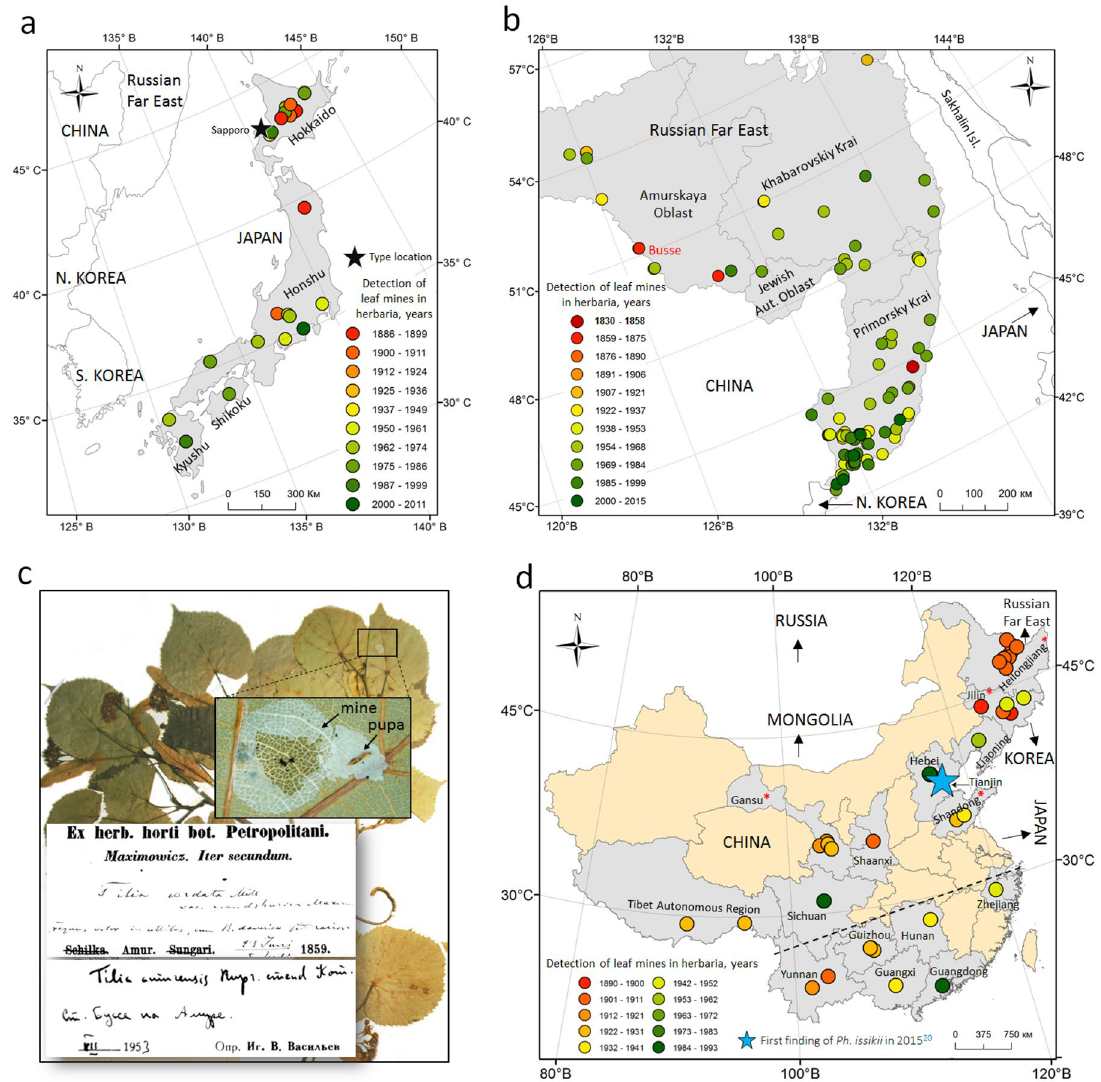
Figure 3. Past distribution of Phyllonorycter issikii in Japan ( a ), the Russian Far East ( b ), and China ( d ) based on findings of leaf mines in herbaria collected in 1859–2015. The village Busse, 1.5 km from the border with the Chinese province Heilongjiang, is the location of the earliest finding of Ph. issikii mines (1859) confirmed by DNA barcoding ( b , c ). In China ( d ), the provinces where typical mines were found in herbaria are shaded in gray; in the provinces marked by an asterisk, the identification of Ph. issikii archival specimens was confirmed by DNA barcoding. The dotted line shows a schematical border between the Palearctic (above the line) and the Indomalaya (below the line). The maps were generated using ArcGIS 9.3 (Release 9.3. New York St., Redlands, CA. Environmental Systems Research Institute, http:// www. esri. com/ softw are/ arcgis/ eval- help/ arcgis- 93). Photographs in Fig. ( c ) taken by N.